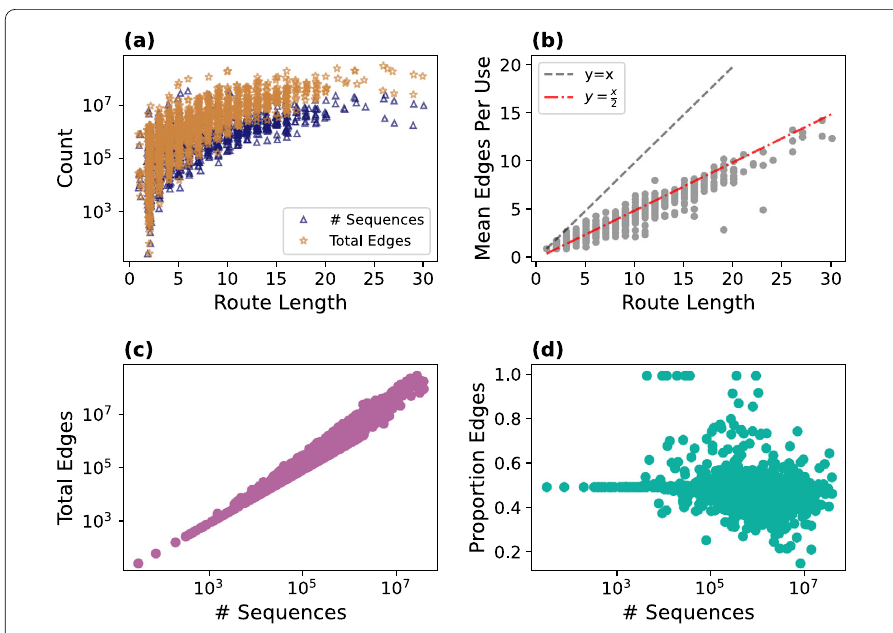
Figure 7 Longer routes use more edges on average, but all routes are not used to the same extent, and not all appearances are equal. Panel ( a ) shows the length of a shipping service route (horizontal axis) against the number of unique route sequences that route appears in (# Sequences, blue triangles), and the total number of edges from that route used across all minimum-route paths (Total Edges, orange stars). Longer service routes tend to be more highly weighted, but some shorter routes are also prevalent in realizing minimum-route paths. Panel ( b ) shows the average number of edges used per appearance in a route sequence for each service route (Total Edges divided by # Sequences). The length of a route is a natural limit on the number of edges that can be used from that route in a given path; if the points were to fall along the line y = x , then each time a route appeared in a route sequence we could expect most or all of its edges to be used in that minimum-route path. On average roughly half of the edges from a route are used whenever it appears in a route sequence ( R 2 = 0.92). Panel ( c ) shows a direct relationship (in logarithmic space) between the number of sequences a route appears in and the total edges used from the route, while ( d ) shows the same quantities but with the y-axis scaled to show the proportion of the maximum possible edges. Values near the bottom indicate that few edges from a route were used with respect to the number of times the route appeared and its length, while high values indicate that each time the route is used all of its